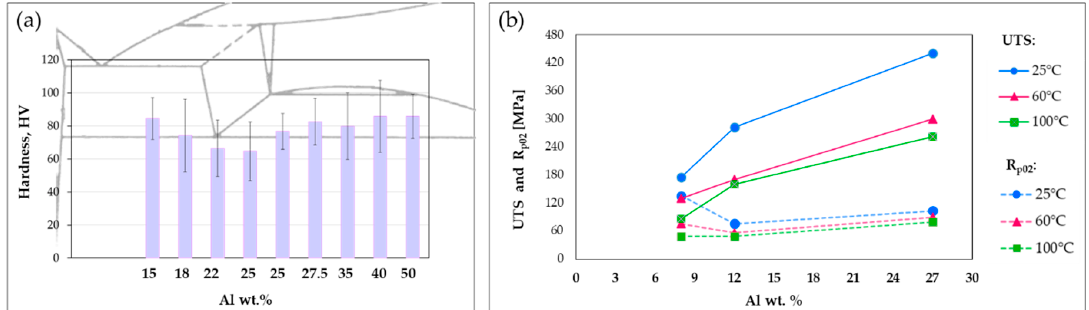
Figure 6. Effect of Al addition on Zn-Al alloys ( a ) hardness (based on data from [30]) and ( b ) tensile and yield strength (based on data from [10]).